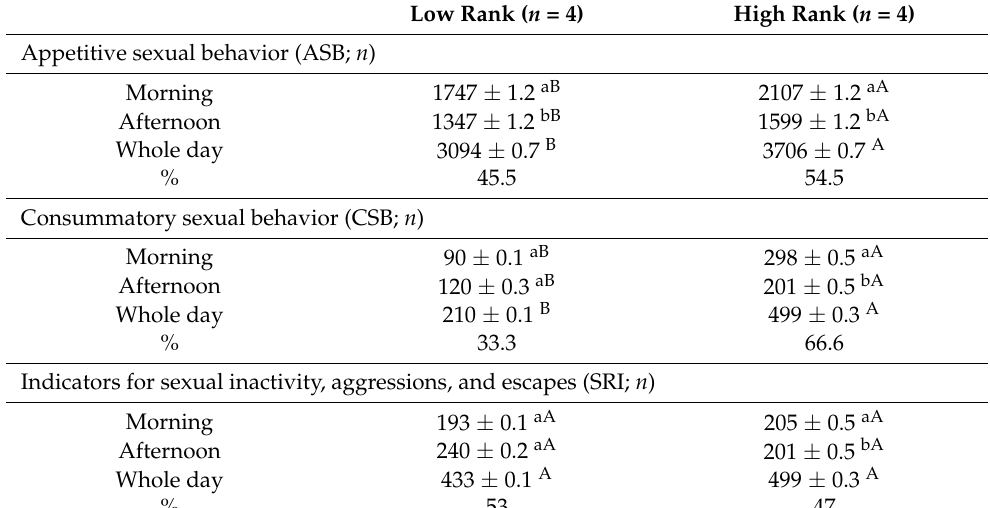
Table 3. Appetitive and consummatory sexual behaviors and sexual inactivity, aggressions, and escape behaviors of adult low or high hierarchy Dorper rams (ASB; n = 8) during the morning or afternoon during the non-breeding